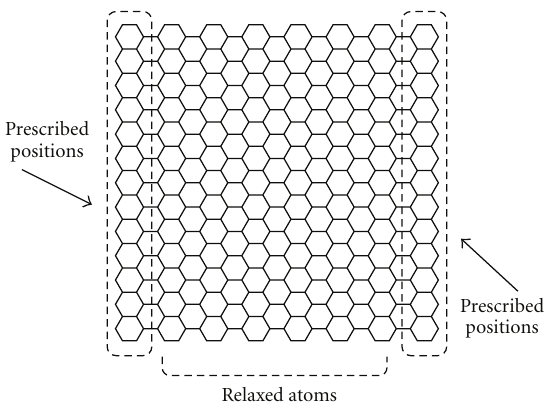
Figure 5: Top view of the top graphene layer. The positions of atoms on the loaded edges of the layer are prescribed during the simulation. Atoms in the middle are free to relax after each displacement of the right edge.